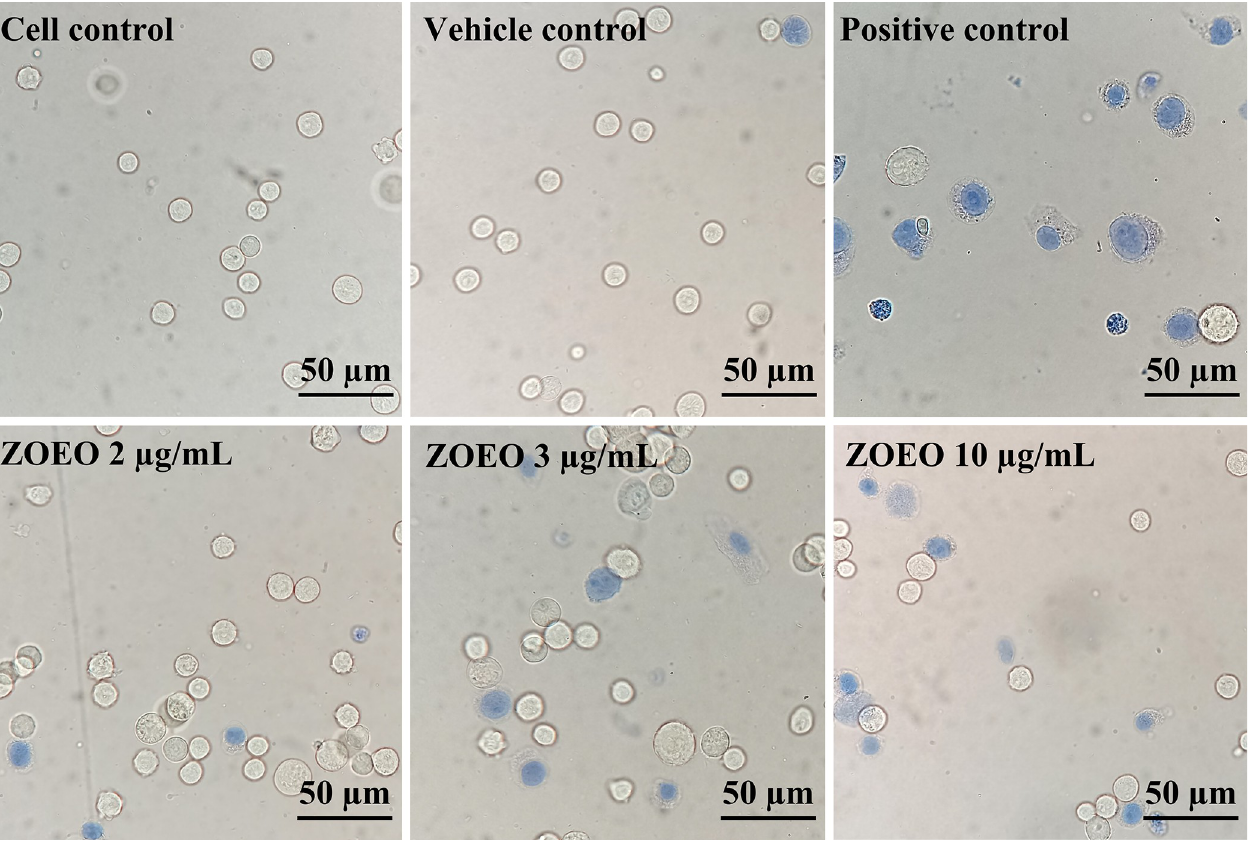
Fig 1. Images (40 × ) of MCF-7 cells after contacted with various concentrations of ZOEO and the controls. Viable cells show colorless and dead cells show blue.